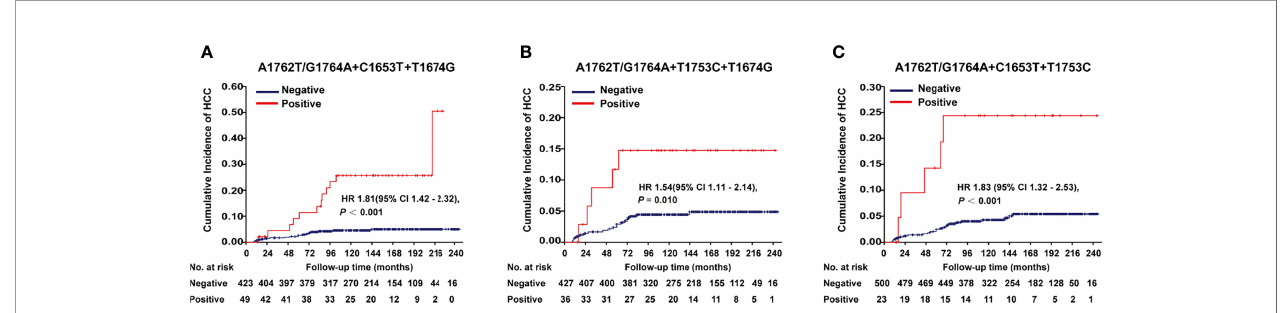
FIGURE 1 | Effects of HBx combo mutations on HCC occurrence in a prospective cohort study with 2114 HBV-infected patients. (A) Effect of A1762T/ G1764A+C1653T+T1674G on HCC occurrence. (B) Effect of A1762T/G1764A+T1674G+T1753C on HCC occurrence. (C) Effect of A1762T/G1764A+C1653T+T1753C on HCC occurrence. Hazard ratio (HR) was adjusted with age and